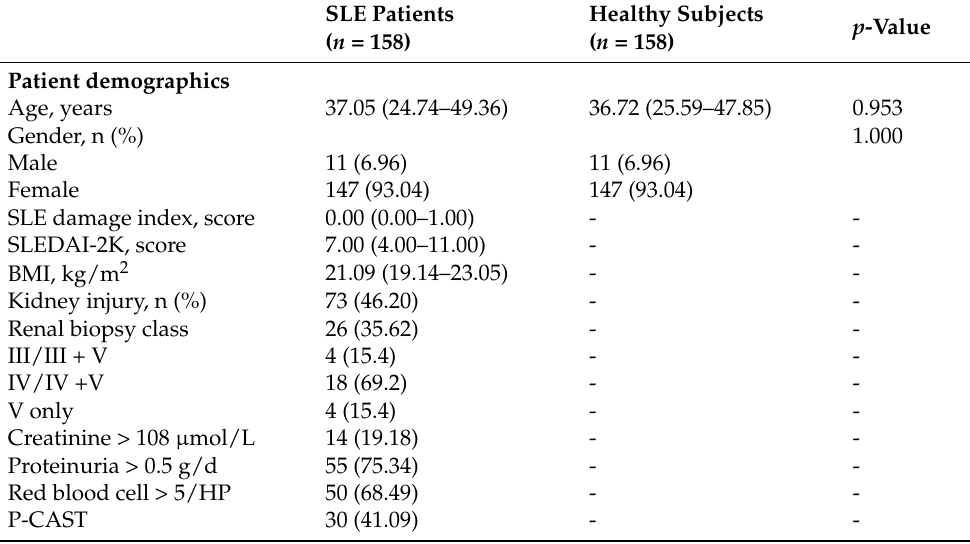
Figure 1. Flow diagram of the study enrolment process. Table 1. Demographics and clinical characteristics of SLE patients and healthy subjects.